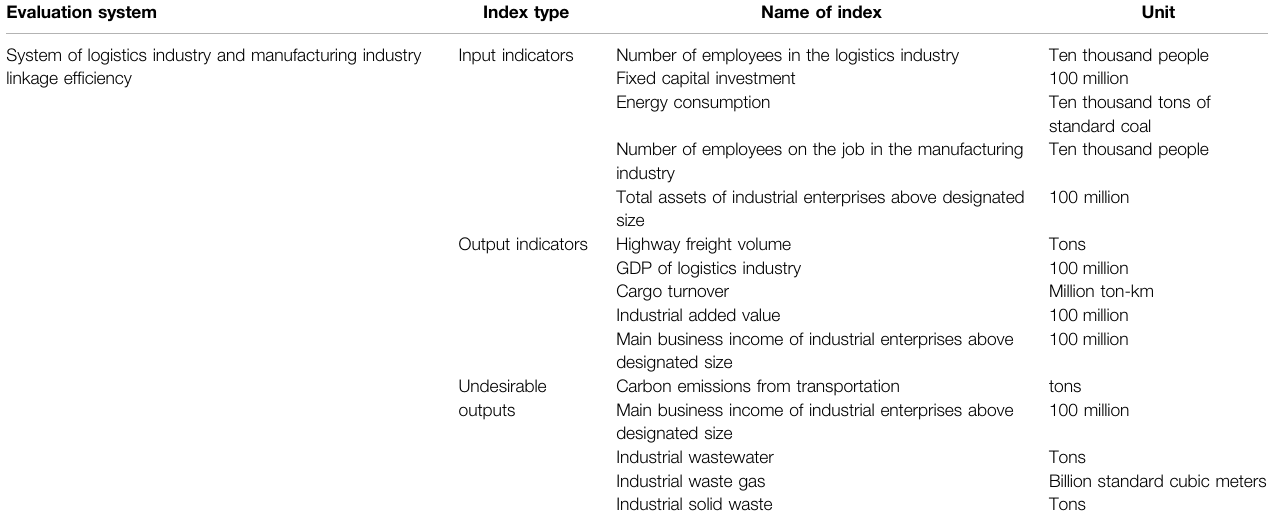
TABLE 3 | Ecological ef fi ciency index of the linkage between logistics industry and manufacturing industry.